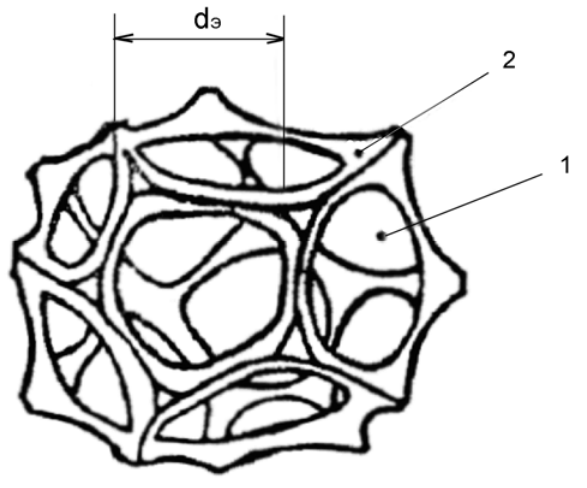
Fig. 2. Structure of pentagondodekaedrical mesh of sedi- mentation from high porosity material: 1 – porous channel; 2 –